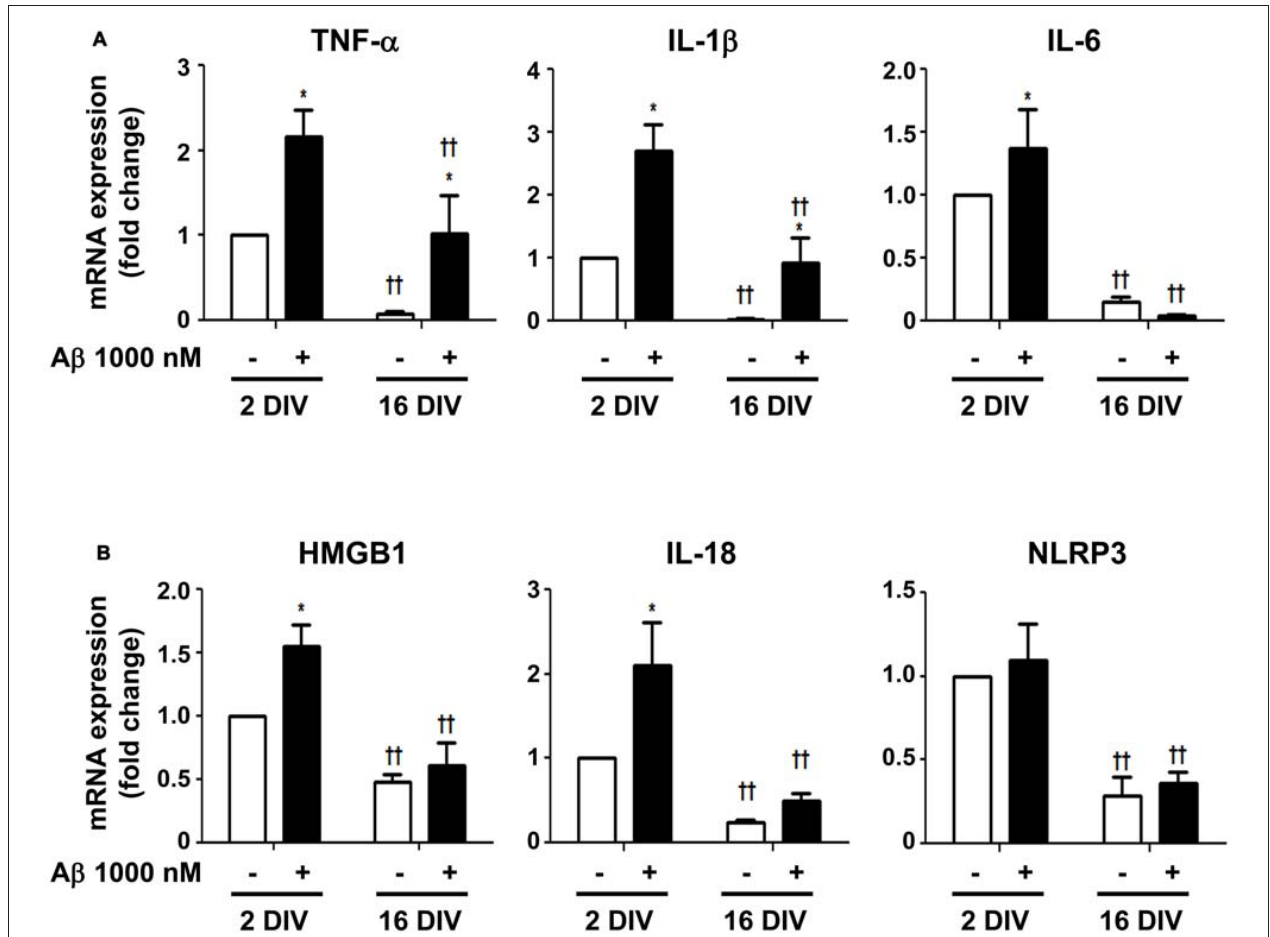
FIGURE 8 | Increased expression of inflammatory mediators in microglia treated with amyloid- β (A β ) peptide is more evident in the reactive cultured cells. Microglia that were kept in culture for 2 and 16 days in vitro (DIV) were treated with 1000 nM A β for 24 h. (A) Expression of inflammatory cytokines [e.g., tumor necrosis factor- α (TNF- α ), interleukin (IL)-1 β and IL-6] and of (B) inflammasome-related proteins [e.g., high-mobility group protein B1 (HMGB1), IL-18 and NOD-like receptor family pyrin domain containing 3 (NLRP3)] were evaluated by Real-Time PCR. Results are expressed in graph bars as mean ± SEM. Cultures, n = 4 per group. Two-way ANOVA ( Post hoc Bonferroni test): ∗ p < 0.05 vs. respective non-treated Control; †† p < 0.01 vs. 2 DIV